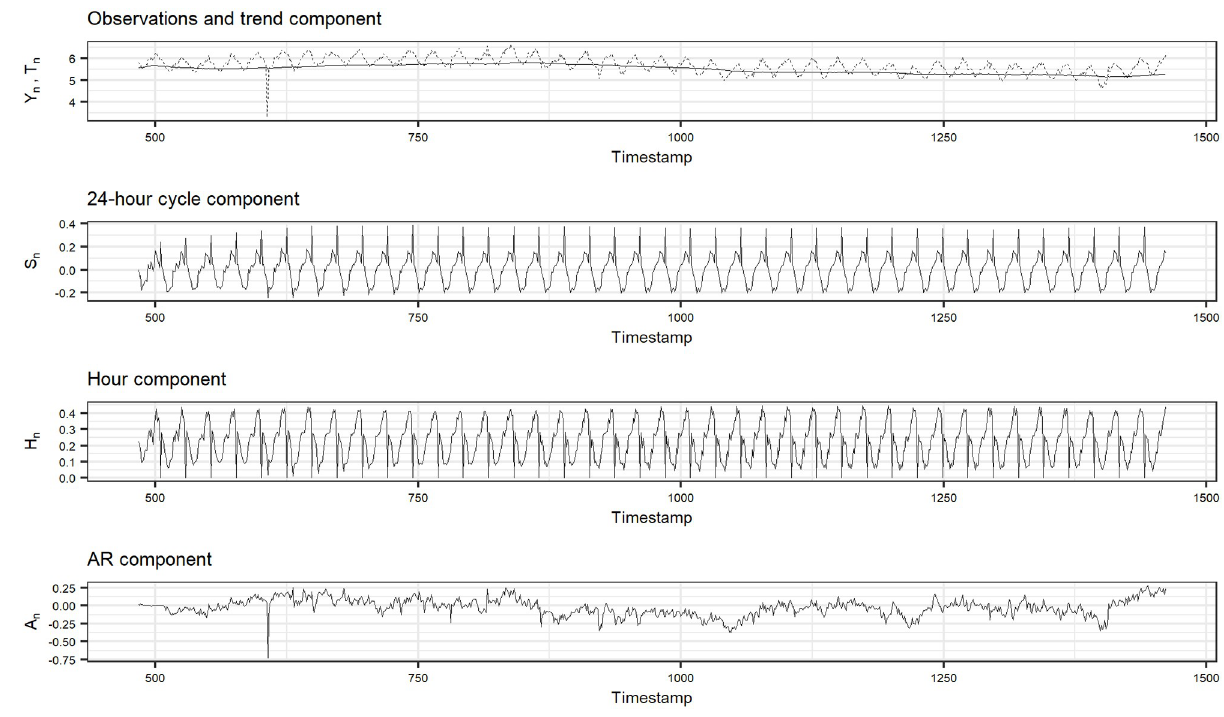
Fig 4. Estimates of the state variables for time series